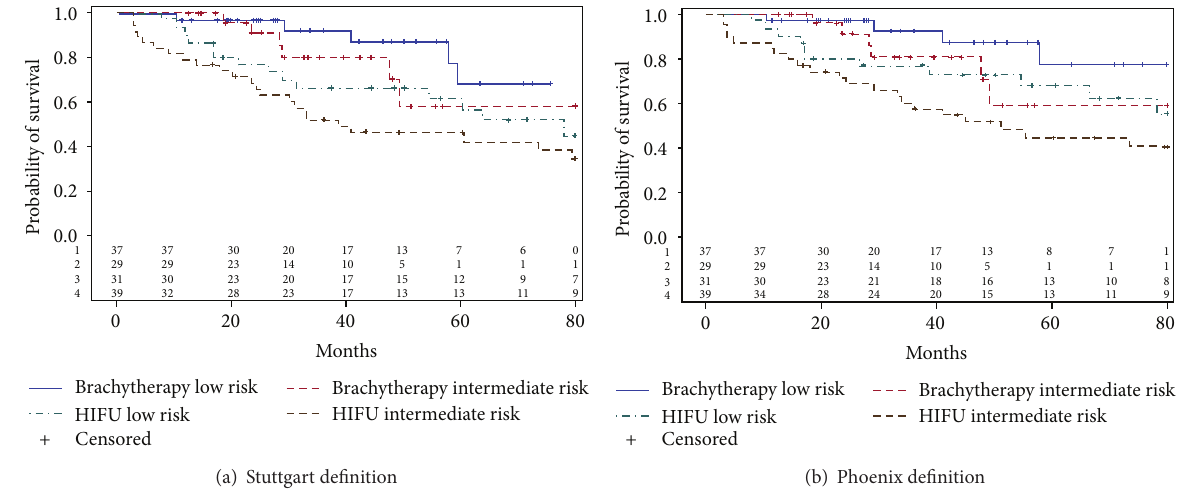
Figure 2: Kaplan-Meier curves for biochemical recurrence-free survival using Stuttgart (a) and Phoenix (b) definitions stratified according to D’Amico risk